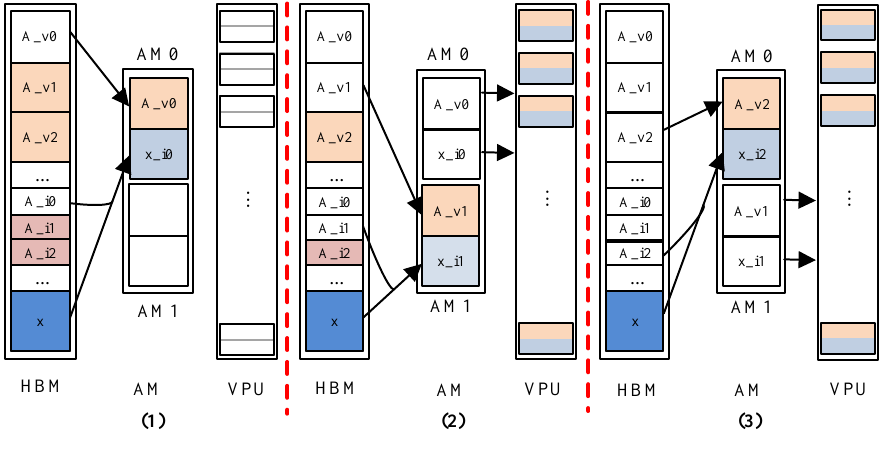
Figure 5. Data movement and